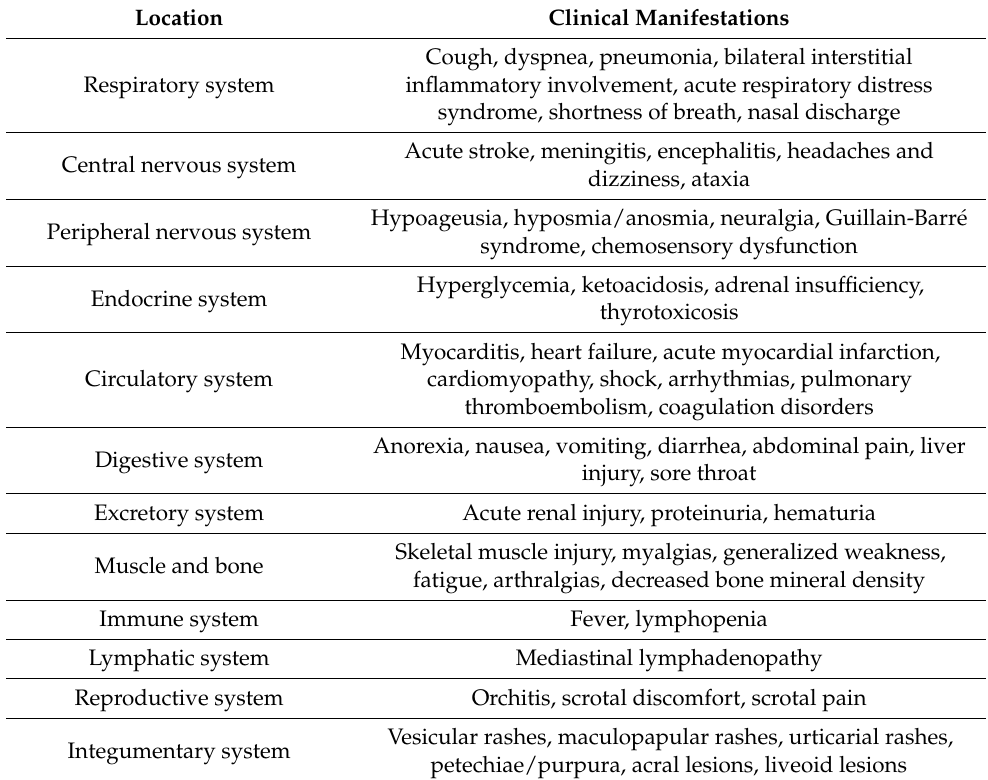
Table 1. Location and classification of clinical manifestations in patients infected with